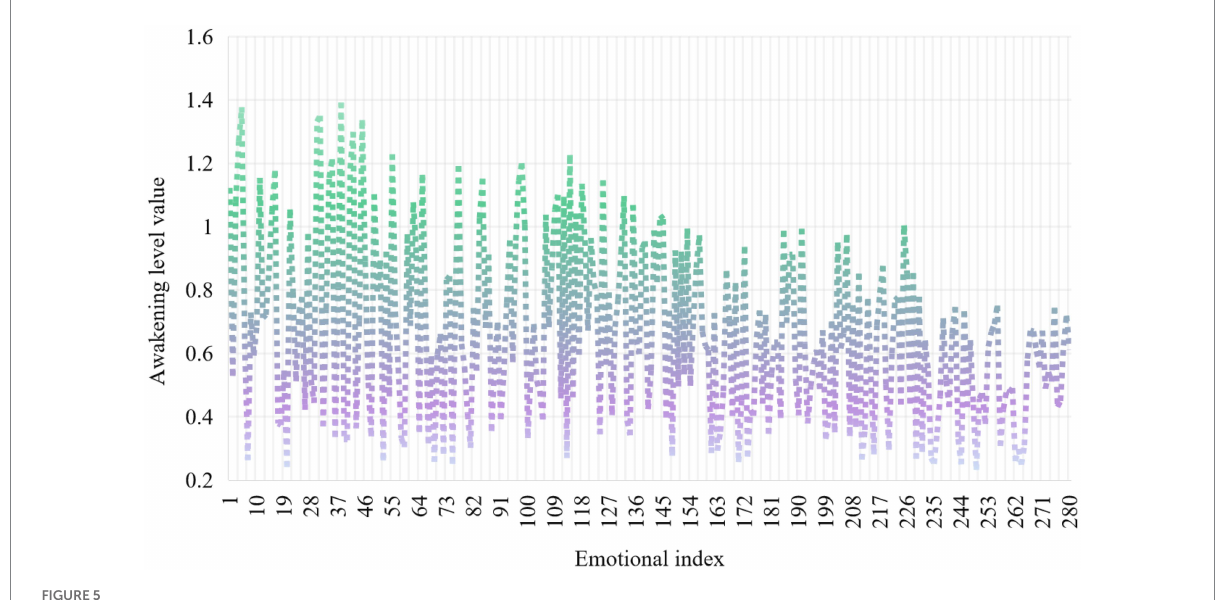
FIGURE 5 Distribution of emotional intensity under the control dimension.